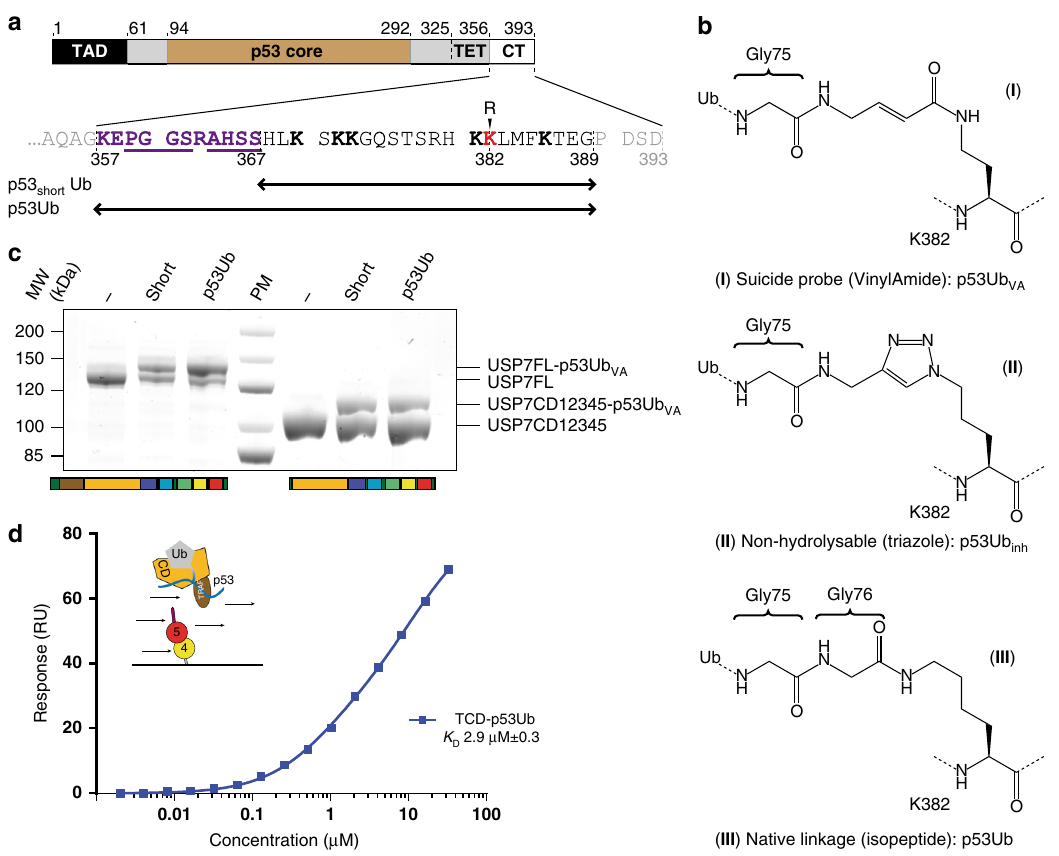
Fig. 4 Development of synthetic p53-derived substrates for USP7. a Schematic domain structure of p53 with trans activation domain (TAD), core region, tetramerization domain (TET) and C-terminal region indicated (CT). Close-up of CT highlights lysines (bold) known to be ubiquitinated 39 and the TRAF recognition motif (underlined) 29,43 . K382 (red) is used as target lysine in the synthetic p53Ub reagents, underneath the sequence coverage of the peptides is indicated. b Three synthetic p53Ub-peptides are generated with different linkage types: covalently binding (vinylamide linkage, ( I )), uncleavable (triazole linkage, ( II )) and cleavable (native linkage, ( III )). c The af fi nity of USP7 for the covalent-binding p53Ub VA increases if the TRAF domain is present. USP7 constructs with and without TRAF domain have been incubated with the probe for 15min at RT and analysed on a Coomassie gel. d The af fi nity of Ubl45 for the substrate-bound TCD is similar to CDUb (2.9 µ M compared to 0.59 µ M, Fig. 3c). Around 50 units of Ubl45 were immobilized on the chip before a titration range of p53Ub-bound TCD was fl own over. Their equilibrium binding values were plotted and fi tted to get the displayed K D -value, with the SD